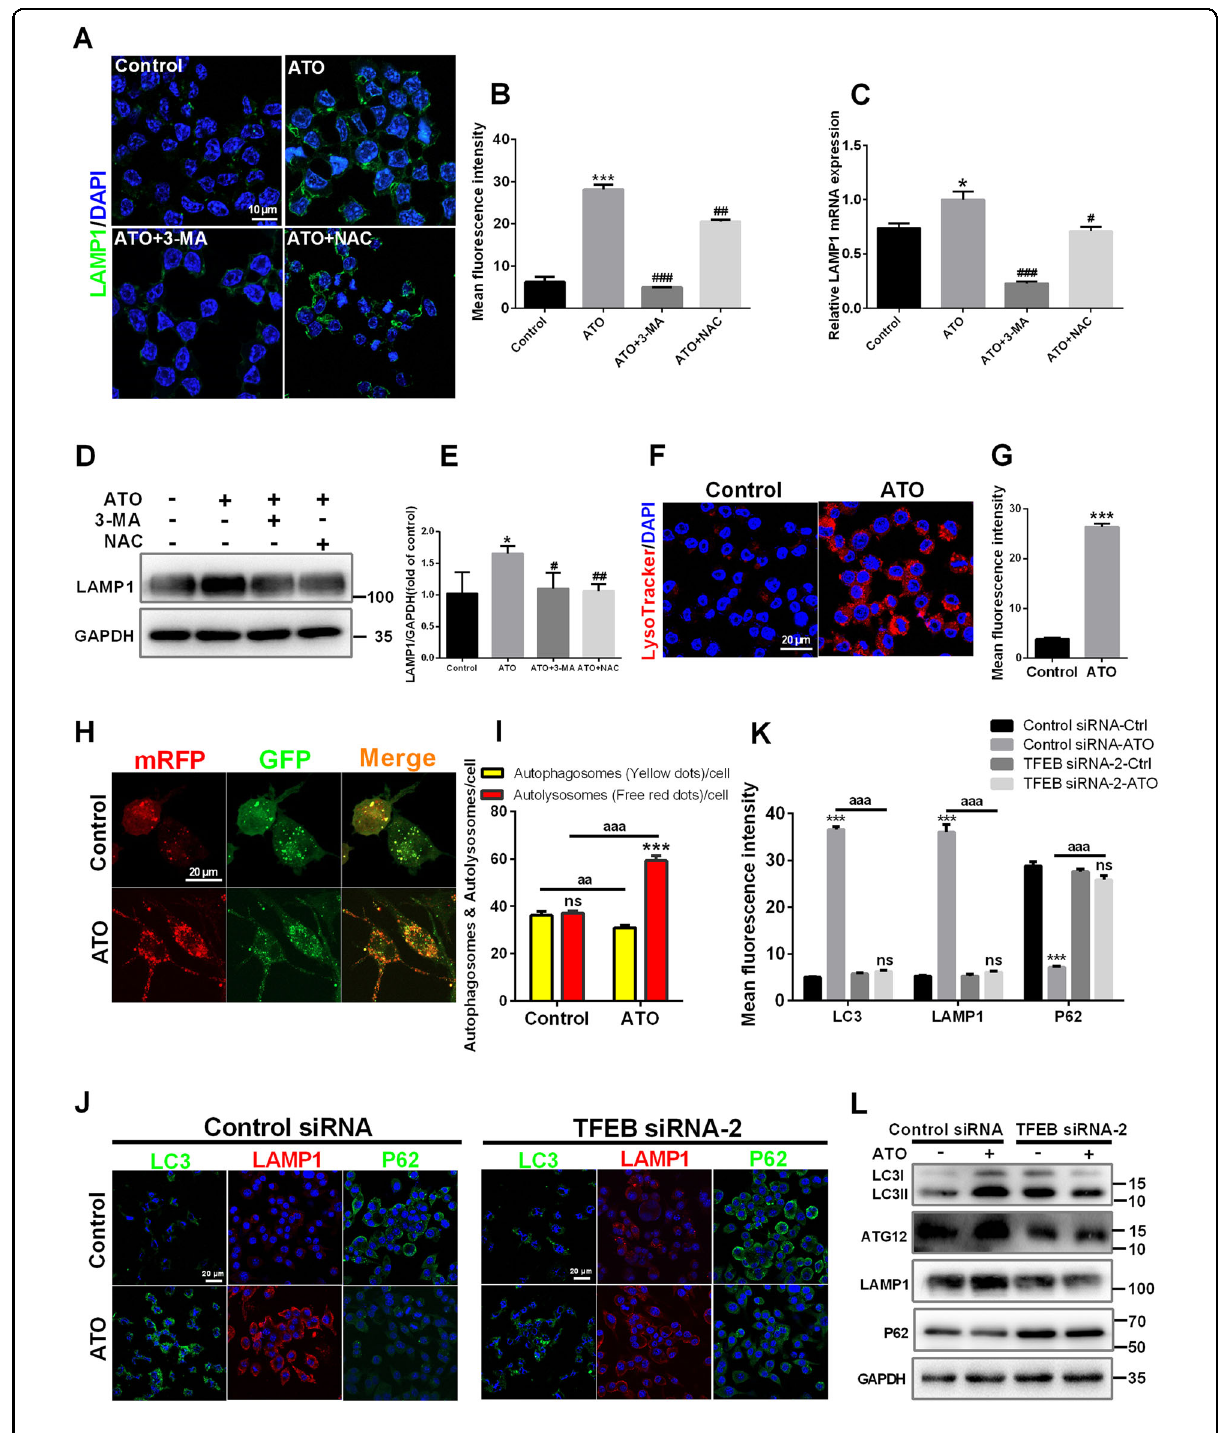
Fig. 5 (See legend on next